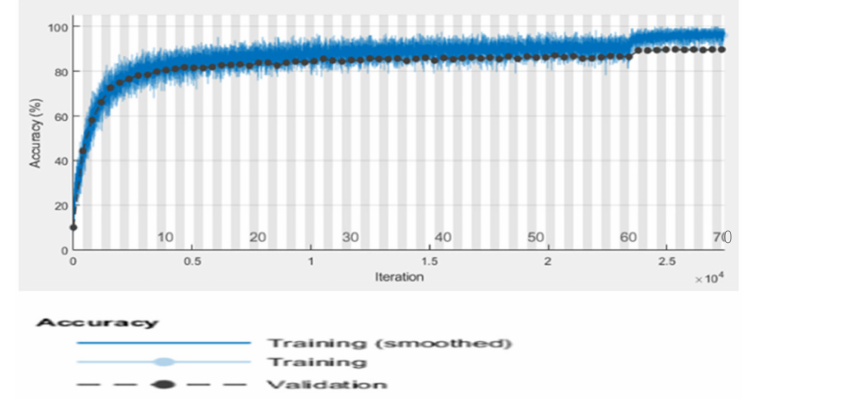
Figure 10. CNN model accuracy.